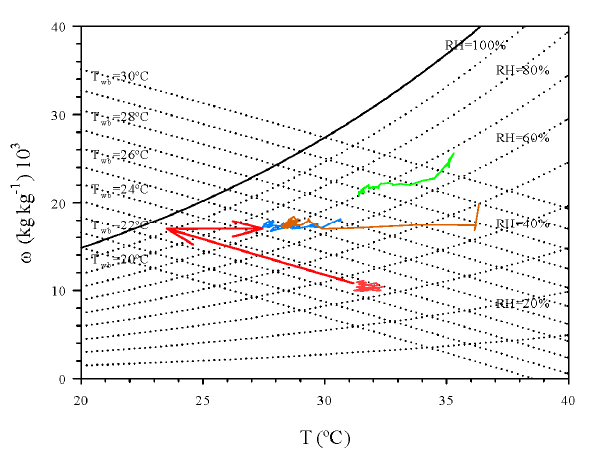
Figure 5. State of the air outdoors (red), in the pre-chamber (blue), at the end of the air duct (orange) and in the greenhouse (green) during test 1 when using the fan-pad system. The red arrows represent the evaporative cooling of the air in the pad (which was tilted) and its heating (horizontal) in the pre-chamber.